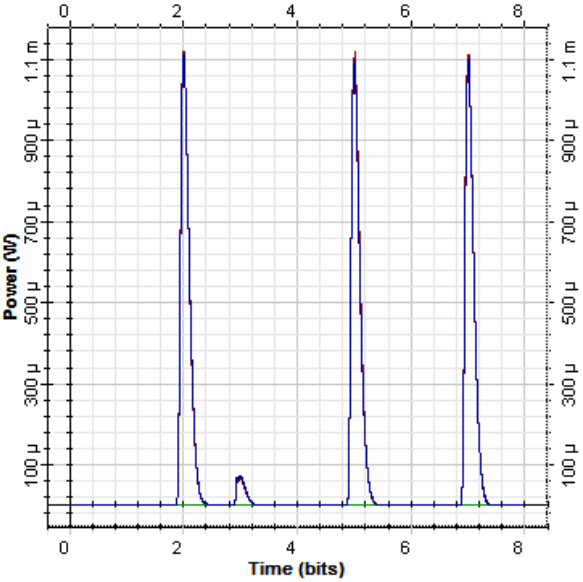
Figure 3. Time domain output for BPF1.